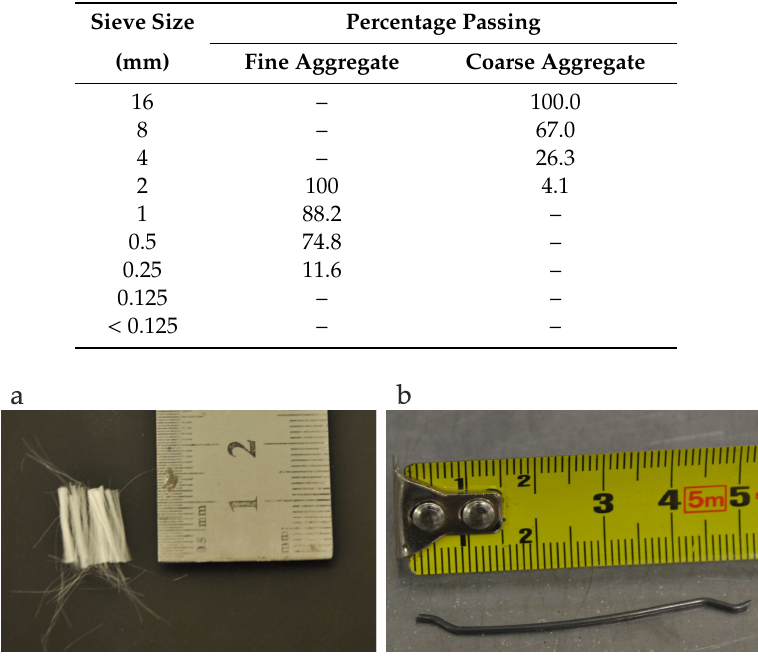
Figure 1. ( a ) Polypropylene fibres and ( b ) steel fibres.